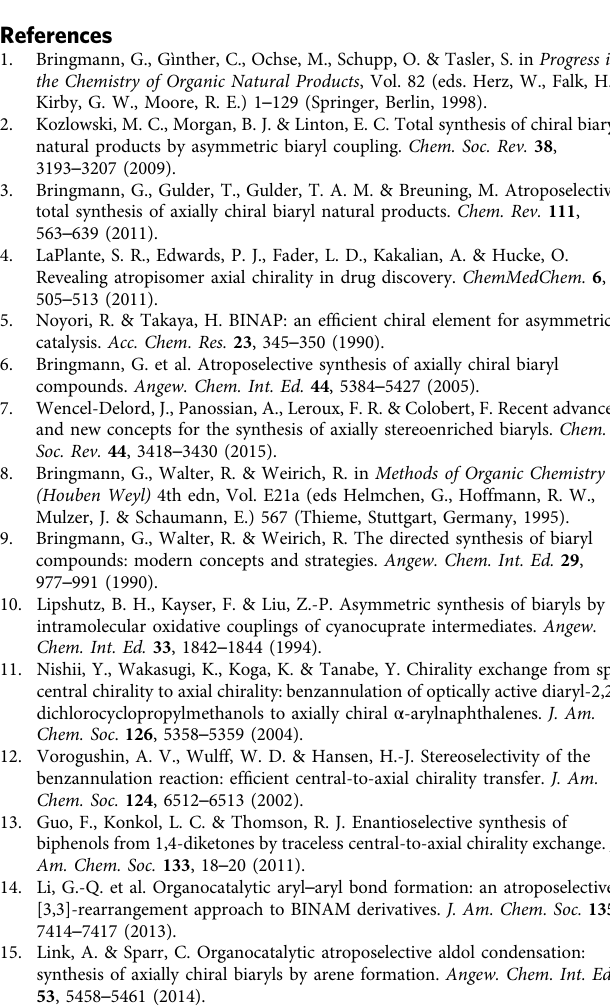
Figs. 1 – 167. For the details of the synthetic procedures, see Supplementary Methods. The supplementary crystallographic data for this paper could be obtained free of charge from The Cambridge Crystallographic Data Centre ( 3au: CCDC 1501039) via